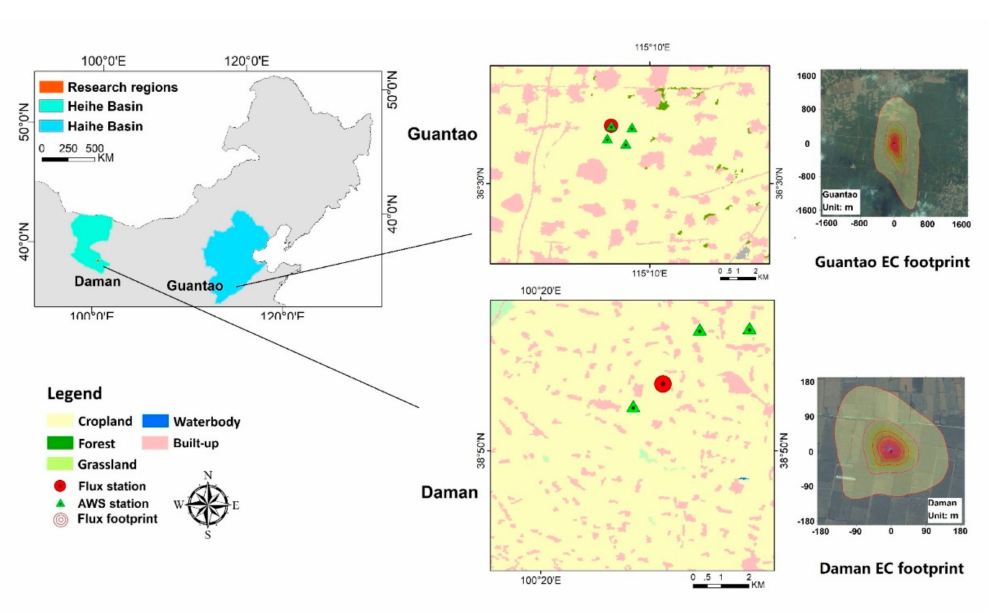
Figure 2. Locations and land cover types of the research regions. The flux station locations are marked on the maps, with photos of the flux footprints shown below. The flux observation footprints are calculated using the flux footprint prediction model [45]. EC: eddy covariance and AWS: automatic weather